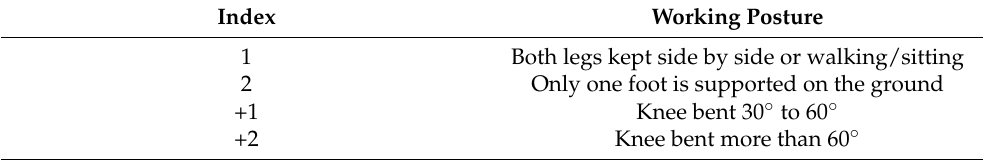
Table 6. Classification based on the leg posture.